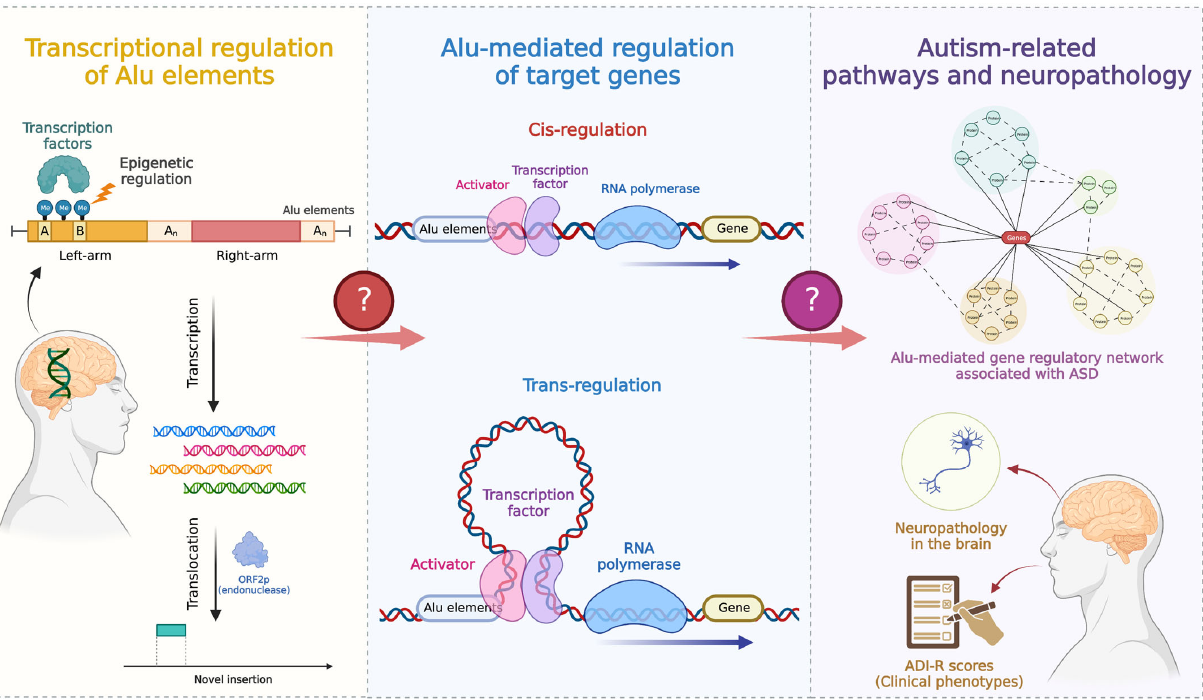
Figure 1. The conceptual framework of this study. This figure shows the structure and transcrip ‐ tional regulation or retrotransposition of Alu elements through epigenetic mechanisms. Alu ele ‐ ments can act as enhancers or alternative promoters for host/target genes, resulting in transcriptome alteration because they contain several transcription factor binding sites [17,26,27]. It is unclear whether Alu elements are associated with the transcriptome, neuropathology, and clinical pheno ‐ type (ADI ‐ R scores) of the brain tissues of ASD individuals. This figure was created with BioRen ‐ der.com (accessed on 19 March